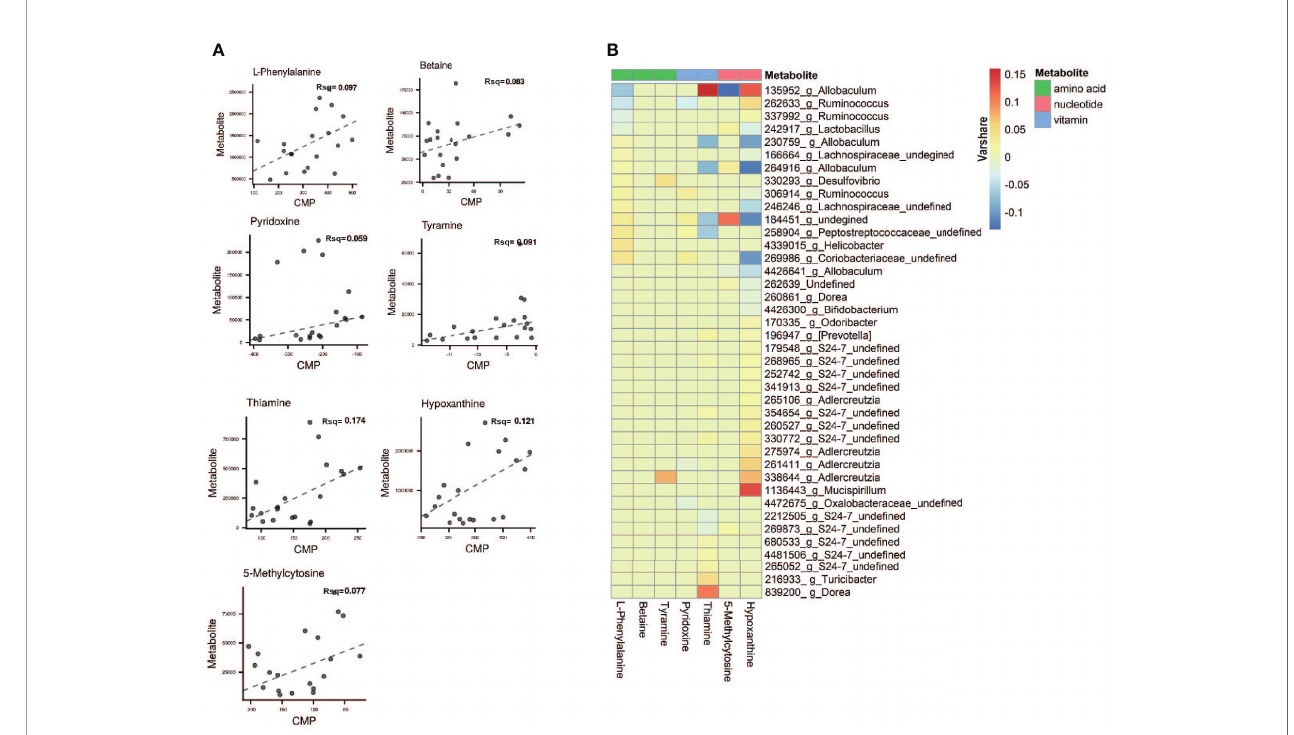
FIGURE 9 | Microbial contribution to metabolite variance based on MIMOSA2. (A) Comprison plots showed the overall relationship between community-level metabolic potential scores (CMP) and metabolite measurements. R-square (Rsq) of the regression model used for prediction represents the sum of the contributions of all listed taxa to the metabolite variance. Contribution results are only included for metabolites with a model p-value less than 0.1 and positive slope of model. (B) Contribution heatmap showed the major taxonomic contributors with Varshare more than 0.01 to variation for each metabolite, red represents positive contribution; blue represents negative contribution; the darker the color, the greater the contribution. “ Varshare ” represents the fraction of the variation in each metabolite explained by the taxon in question, according to the overall community model.